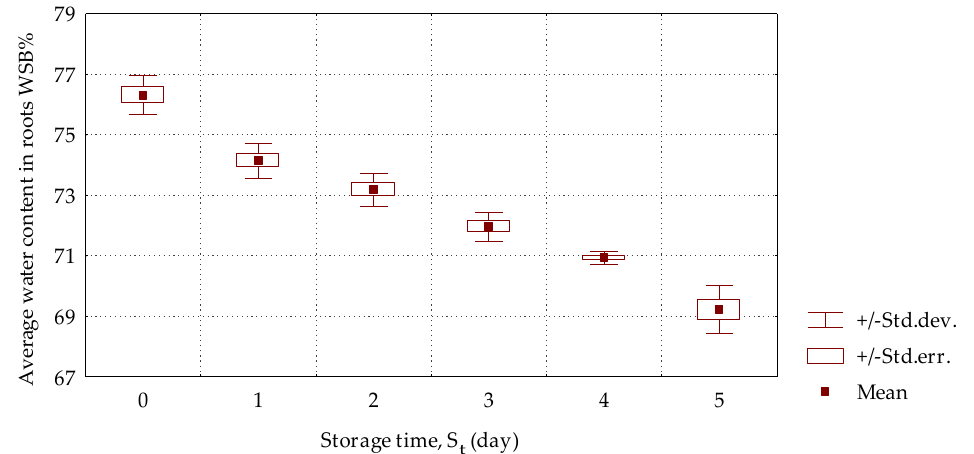
Figure 8. Average water content, WSB% , in the beet roots in the surrounding impact sites depending on the storage day.